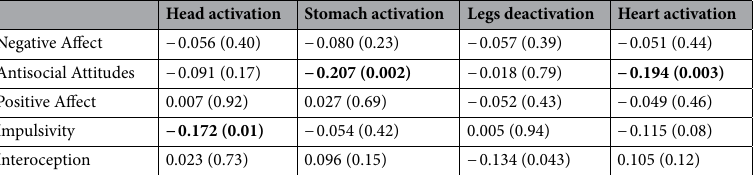
Table 1. Correlations of personality and body map principal components. Spearman’s rank correlation coefficients are presented with uncorrected p values in brackets. Significant or marginal results after FDR- correction for multiple comparisons are highlighted in